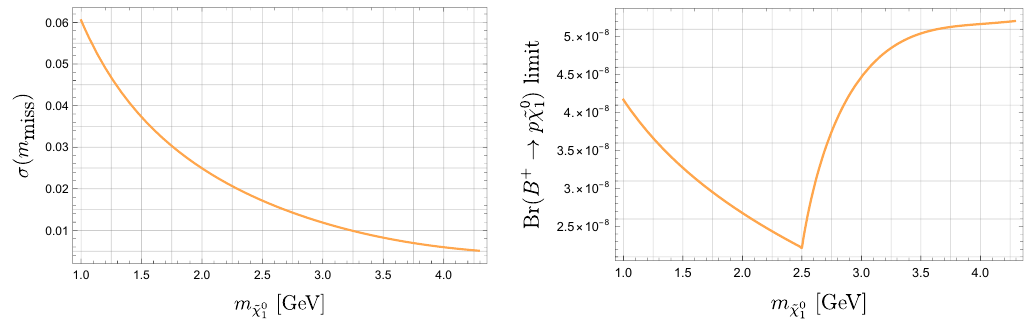
Figure 5 . The missing-mass resolution σ ( m miss ) (left) and the expected Belle II 90% confidence-level upper limit on the branching fraction Br ( B + → p ˜ χ 0 upper limit decreases with the decreasing value of σ ( m miss ) but increases for m the increasing background. The kink at 2 . 5 GeV results from the simple parameterization of the background governed by the limited data available in ref.